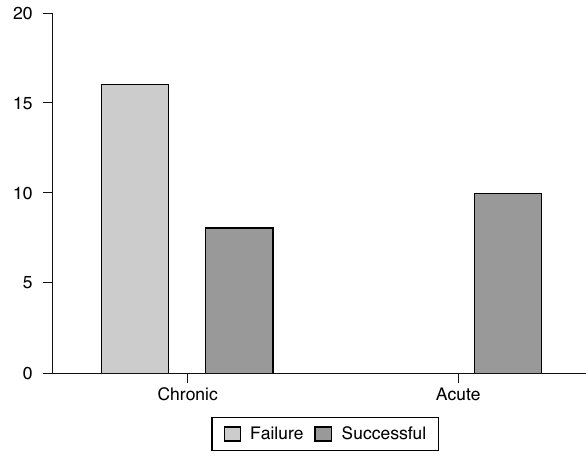
Figure 4 Correlation of patients in group 1 (chronic) and group 2 (acute) with the chances of success with balloon laryn- goplasty.